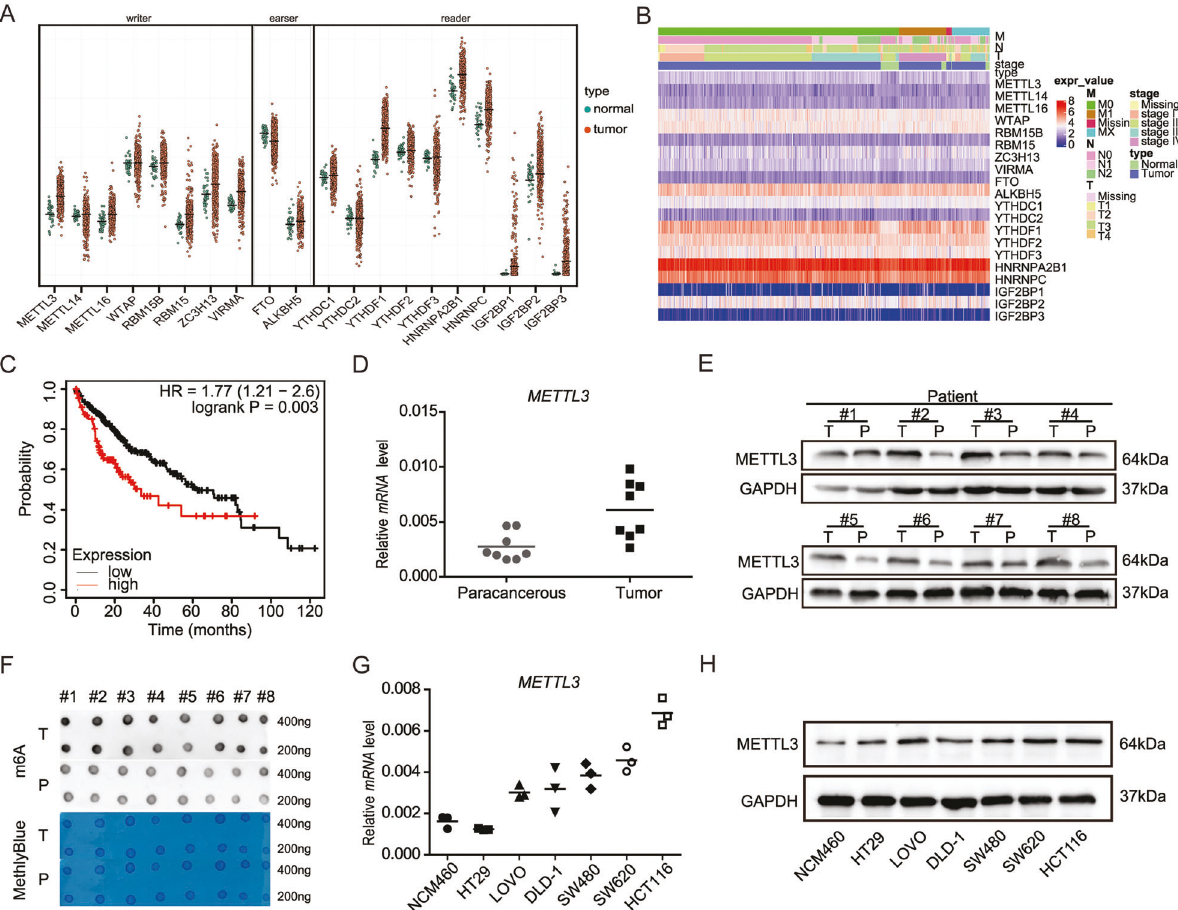
Fig. 1 METTL3 is highly expressed in CRC and associated with clinical features. A , B Heat map pro fi le and histogram showing the expression of m6A modi fi cation related genes in the COAD TCGA database. C Kaplan-Meier analysis of the association of METTL3 expression with overall survival in COAD patients. D , E qRT-PCR and western blot analysis of METTL3 expression in CRC tissues from eight patients. F m6A dot blot assay of tissue samples (cancer and paracancer) from eight patients with CRC. MB, methylene blue staining (as loading control). G , H Real-time PCR and immunoblotting analyses of METTL3 expression in normal colonic epithelial and CRC cell